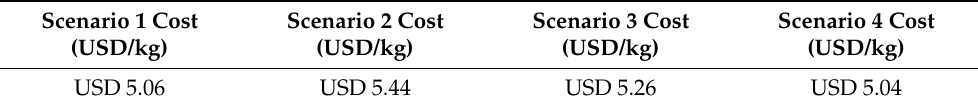
Table 5. Breakdown of the solvolysis processing cost per kg of CFRP for the four